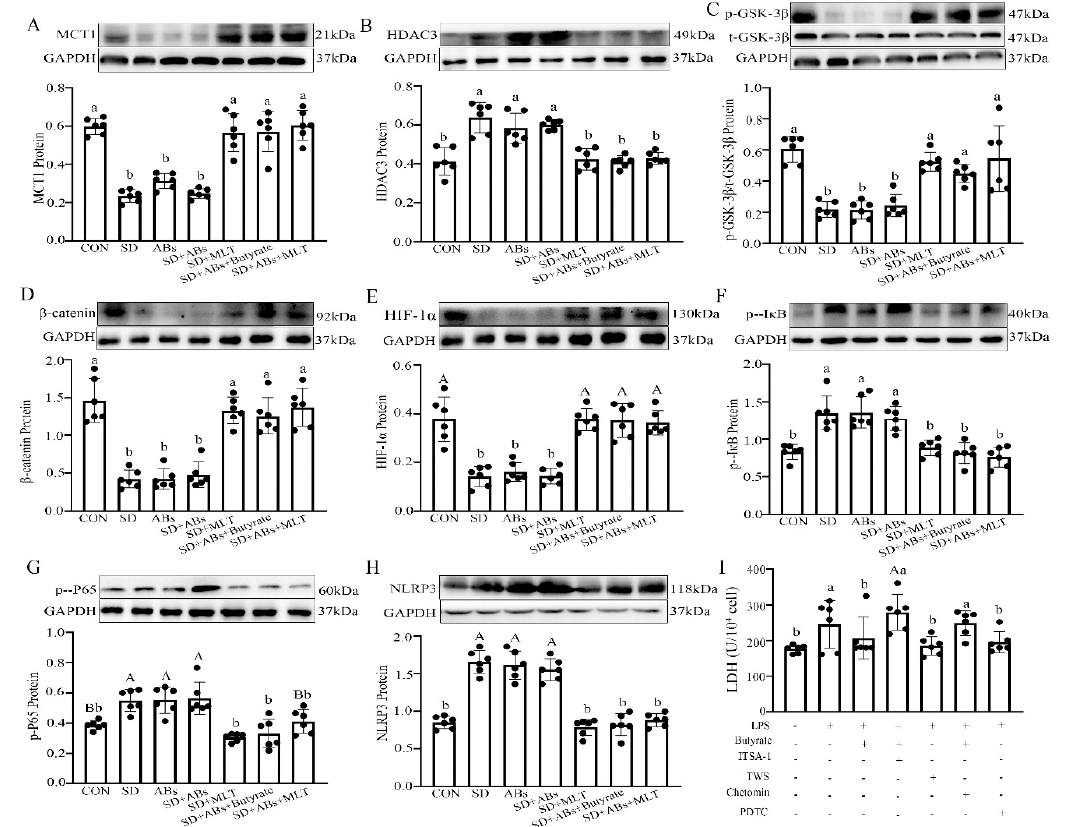
Figure 6. Effects of melatonin and butyrate supplementation on the relative levels of MCT1 ( A ), HDAC3 ( B ), p-GSK-3 β ( C ), β -catenin ( D ), HIF-1 α ( E ), p-I κ B ( F ), p-P65 ( G ), and NLRP3 ( H ) in the colon of the CON, SD, ABs, Abs + SD, SD + MLT, Abs + SD + Butyrate, and Abs + SD + MLT groups ( n = 12). LDH index in LPS-treated IECs ( I ). Chetomin, an antagonist of HIF-1 α ; PDTC, an antagonist of NF- κ B; ITSA-1, an agonist of HDAC3; TWS, an antagonist of GSK-3 β . Values are presented as the mean ± SE. Differences were assessed using ANOVA and are denoted as follows: different lowercase letters or different uppercase letters: p < 0.05; different letters and one contains uppercase letters and the other is lowercase letters: p < 0.01; same letter: p >